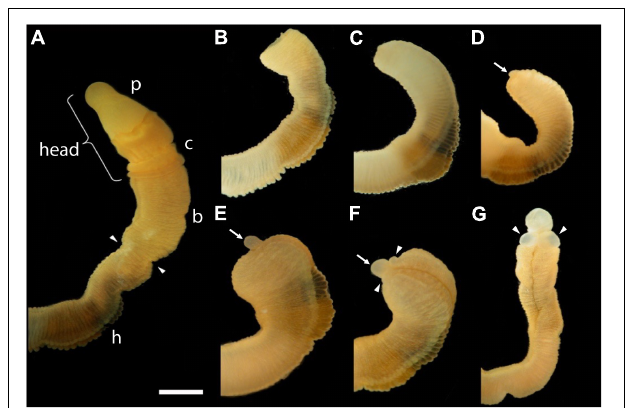
FIGURE 1 | The time sequence of head regeneration of an individual Ptychodera flava . Note that P. flava worms are very hydraulic and the same animal may be extended and thin one moment and contracted and thick the next. (A) The uncut, intact animal. Arrowheads mark the site at posterior end of the gill basket where the animal was severed. Scale bar = 2 mm in all frames. (B) 0 days post-amputation (dpa); gaping anterior wound where the body wall has been severed. (C) 1 dpa; edges of the severed body wall are slightly swollen and smoothened and the wound has begun to close. (D) 3 dpa; wound has closed and a tiny blastema can be detected dorsal to the closure site (arrow). (E) 5 dpa; the blastema is growing rapidly (arrow). (F) 7 dpa; the blastema is shaped into a nascent proboscis (arrow) with a collar (arrowheads). (G) 11 dpa, the new head, approaching final size to match the original body, is attached to the original anterior cut stump. All views of the left side, except (G) , which is more ventral. Arrowheads show the newly regenerating collar. p, proboscis; c, collar; b, branchial region; h, hepatic